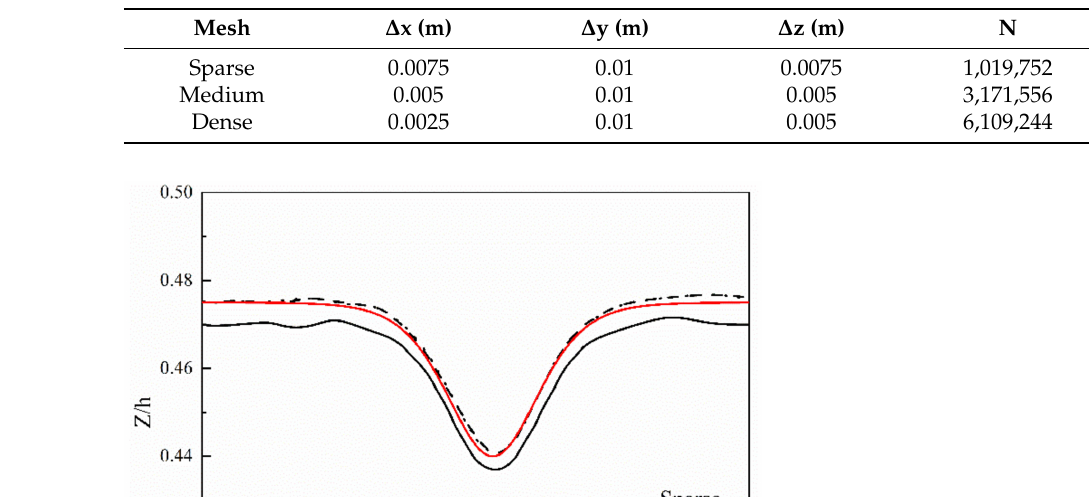
Figure 2. Local Grid Division: ( a ) Sparse gird; ( b ) Medium gird; ( c ) Dense gird. Table 1. Specific parameters of grid division.